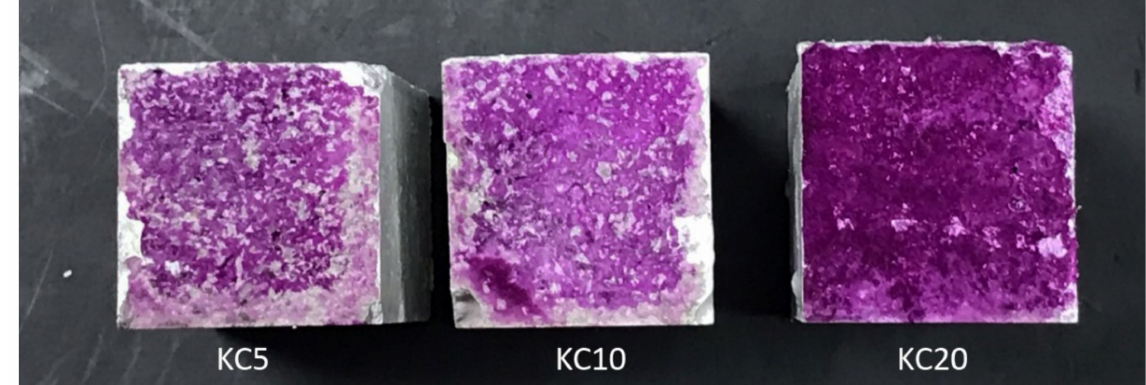
Figure 8. Phenolphthalein test specimens in Series 2 (varied w/b ratio and percentage of WPC).